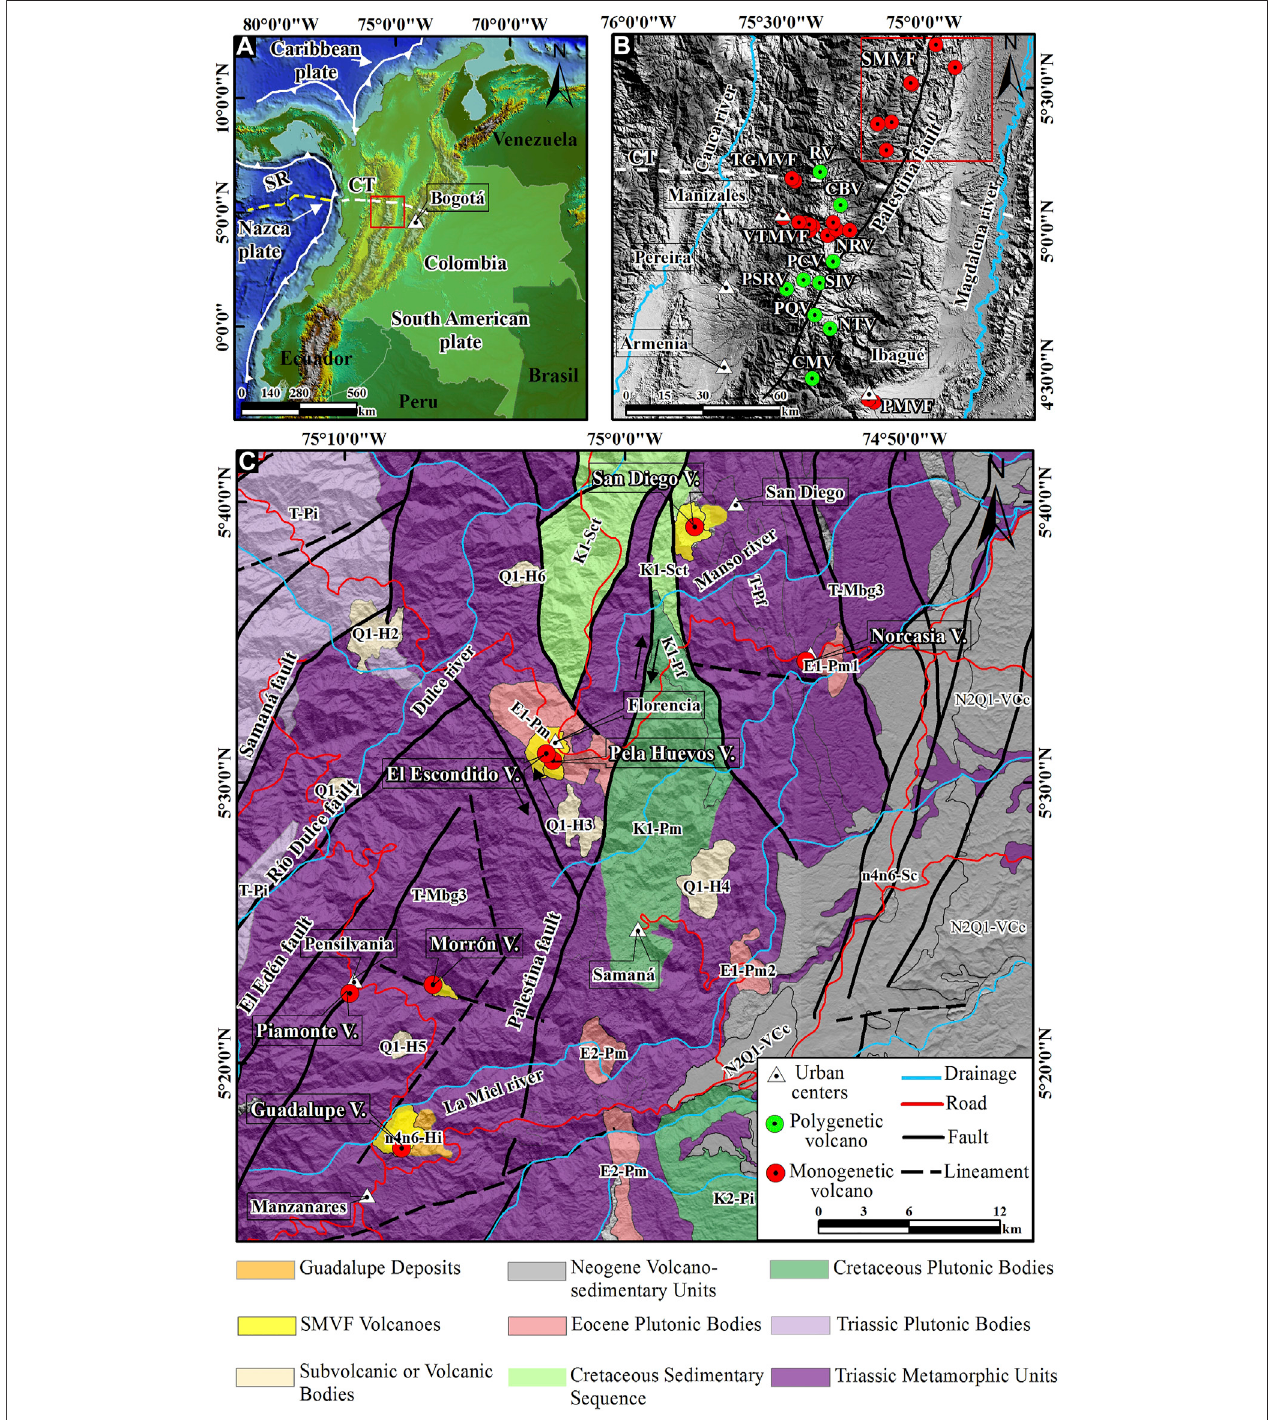
FIGURE 1 | Location maps. (A) Location of Colombia in northern South America. (B) Digital elevation model illustrating the volcanoes that form the San Diego — Cerro Machín Volcano-Tectonic Province. (C) Geological map of Samaná monogenetic volcanic fi eld (Adapted from Gómez-Tapias et al., 2015). SR, Sandra Ridge (yellow dotted line); CT, Caldas Tear (white dotted line); SMFV, Samaná monogenetic volcanic fi eld; TGMVF, Tapias — Guacaica monogenetic volcanic fi eld; VTMVF, Villamaría — Termales monogenetic volcanic fi eld; PMVF, Pijaos monogenetic volcanic fi eld; RV, Romeral volcano; CBV, Cerro Bravo volcano; NRV, Nevado del Ruiz volcano; SIV, Santa Isabel volcano; PCV, Paramillo del Cisne volcano; PSRV, Paramillo de Santa Rosa volcano; PQV, Paramillo del Quindio volcano; NTV, Nevado del Tolima volcano; CMV, Cerro Machín volcano. Geological units: T-Mbg3, Cajamarca Complex; T-Pf, San Diego Gneissic Intrusive; T-Pi, Sonsón